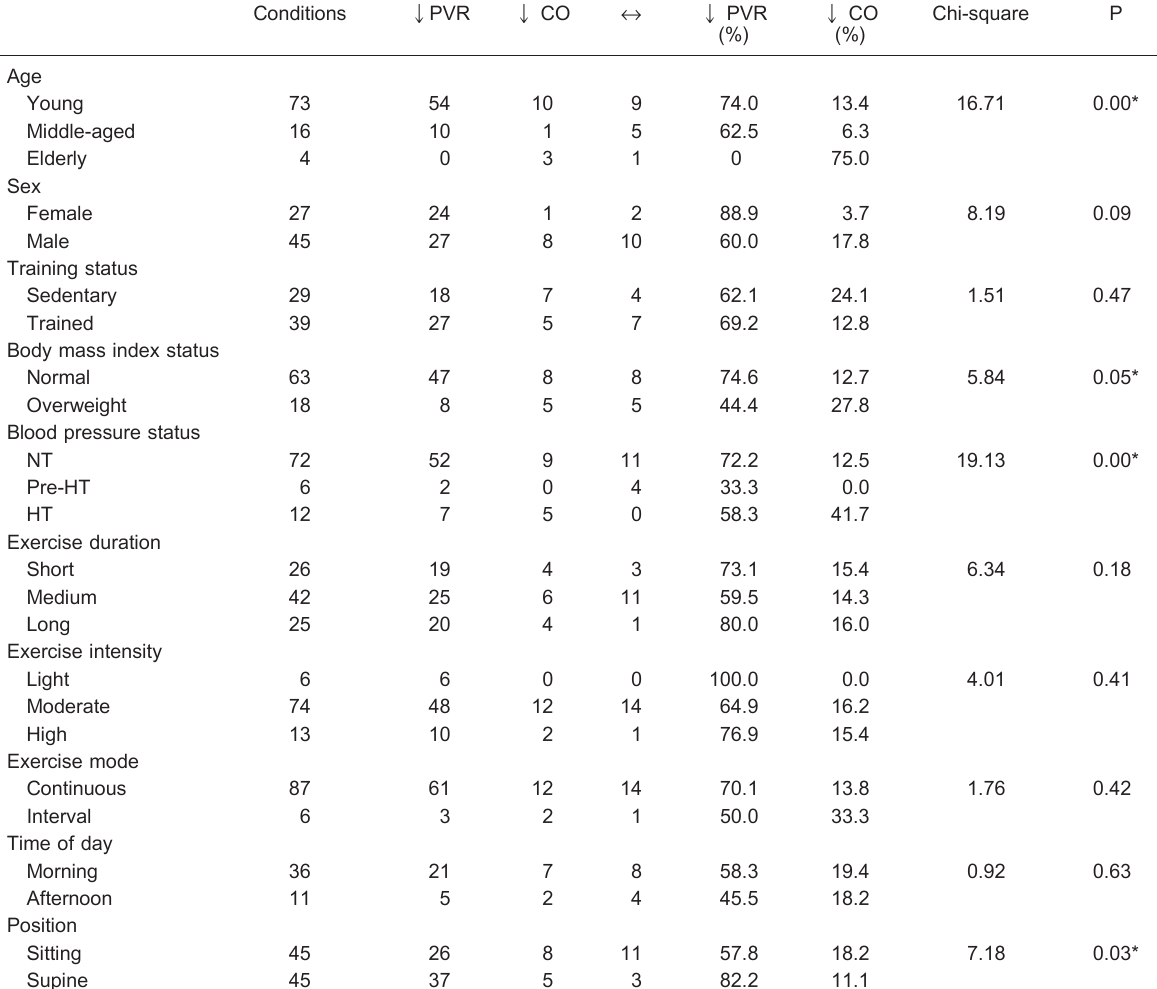
Table 3. Frequency of occurrence of cardiac output (CO) and peripheral vascular resistance (PVR) reduction after aerobic exercise in the different experimental conditions reported in the studies included in this review concerning the possible factors of